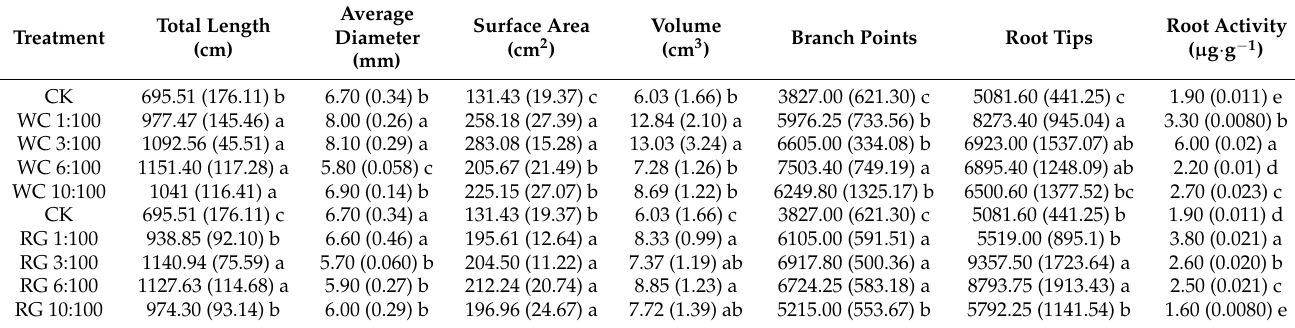
Table 3. Effect of different soil and straw ratios on the corn root system [mean (SD); n = 5].